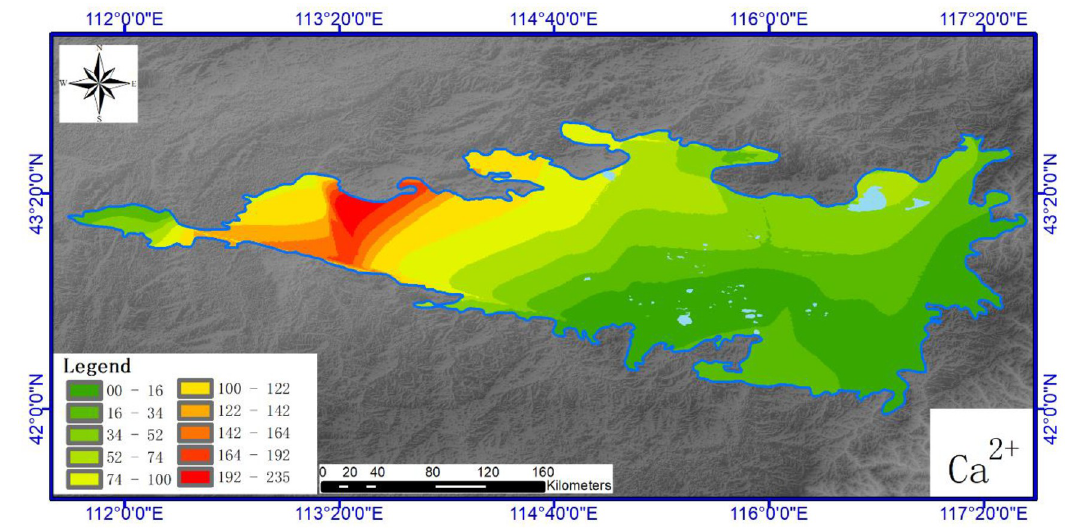
Fig 4. Spatial distribution of soil Ca 2+ in Hunshandake sandy land (Cartographic software:Arcgis10.5).